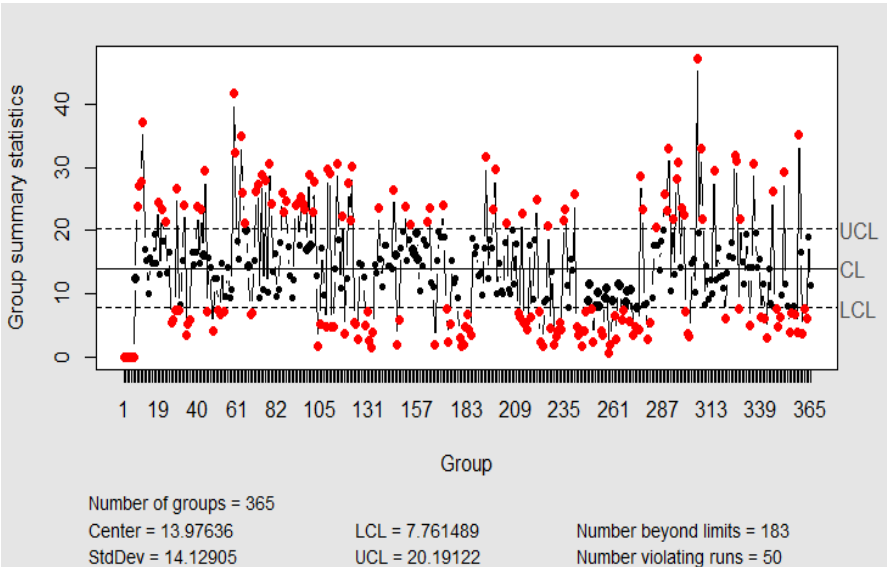
Figure 9. S-chart of hourly NO 2 concentrations with the daily rational subgroup of data. Software: R-programming [56].